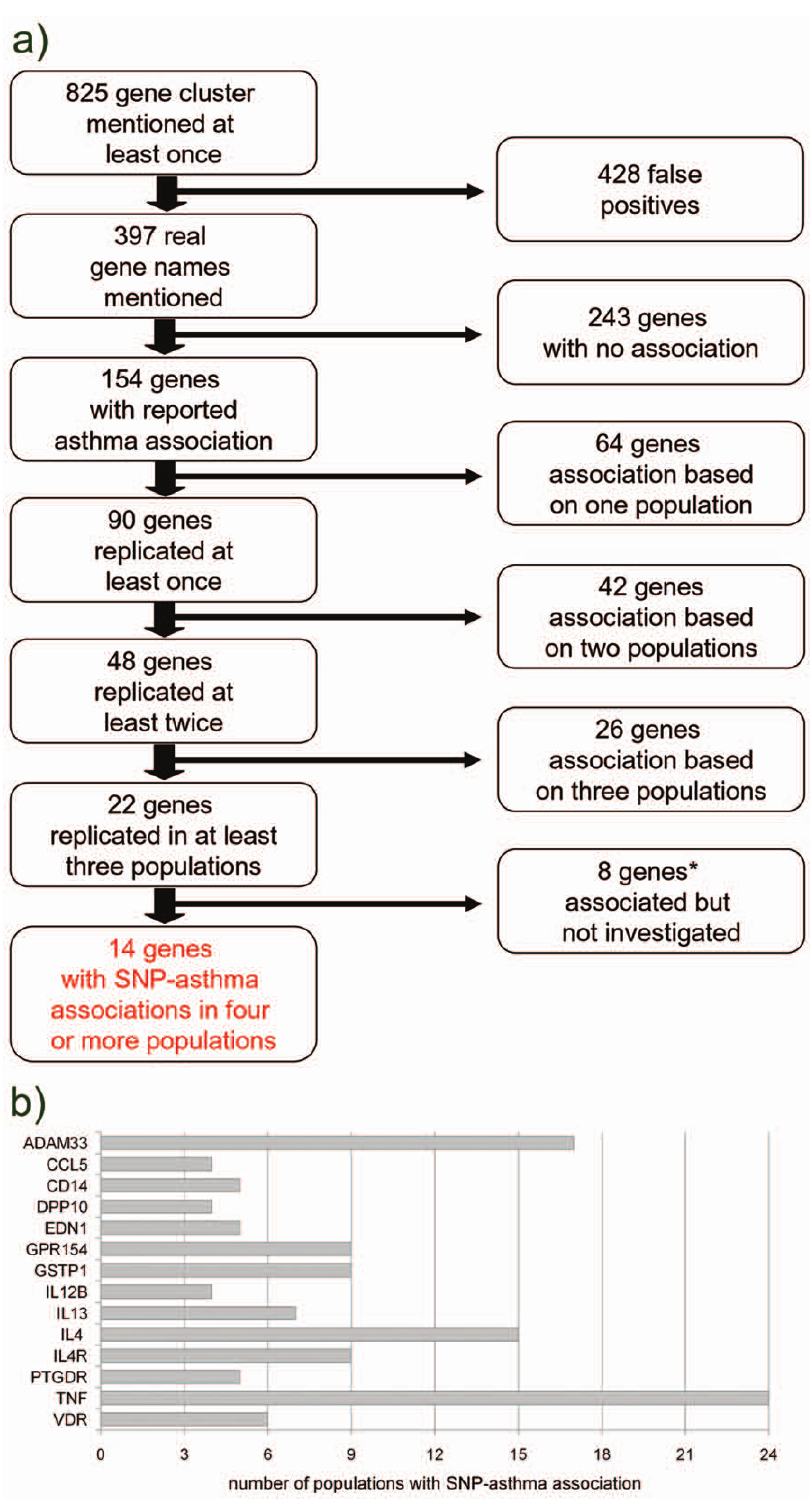
Figure 1. a) Schematic depiction of literature query process. * genes not further investigated were (a) ORMDL3 , originally discovered in this GWA; (b) discovered by other GWAS: CHI3L1 , IL1RL1 , MYB , WDR36 (c) NOS1 where CA-repeats and not SNPs were reported; (d) gene deletions